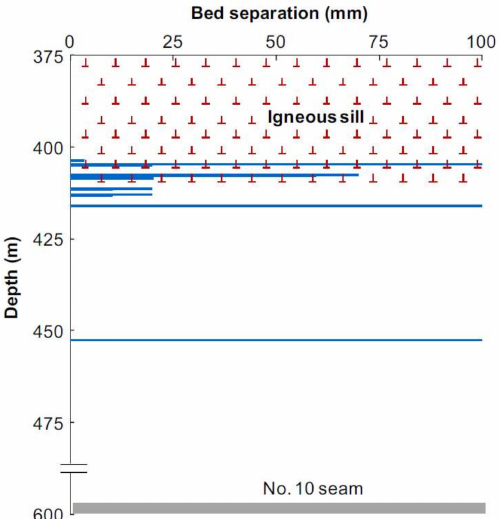
Figure 14. Detection result of bed separation [8].